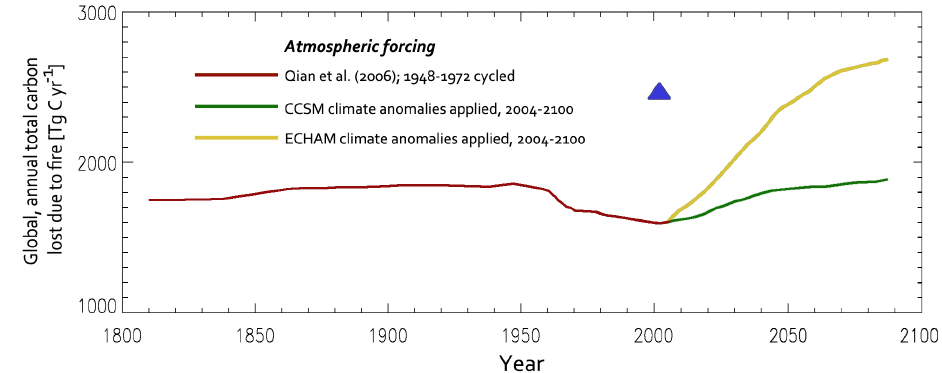
Fig. 2. Timeseries of the total C lost due to fires plotted from the output of the Kloster et al. (2012) Community Land Model (CLM) simulations. The timeseries is smoothed using a 25-yr running average. The 1997 to 2006 annual average value from the GFEDv2 is shown as a blue triangle for comparison.